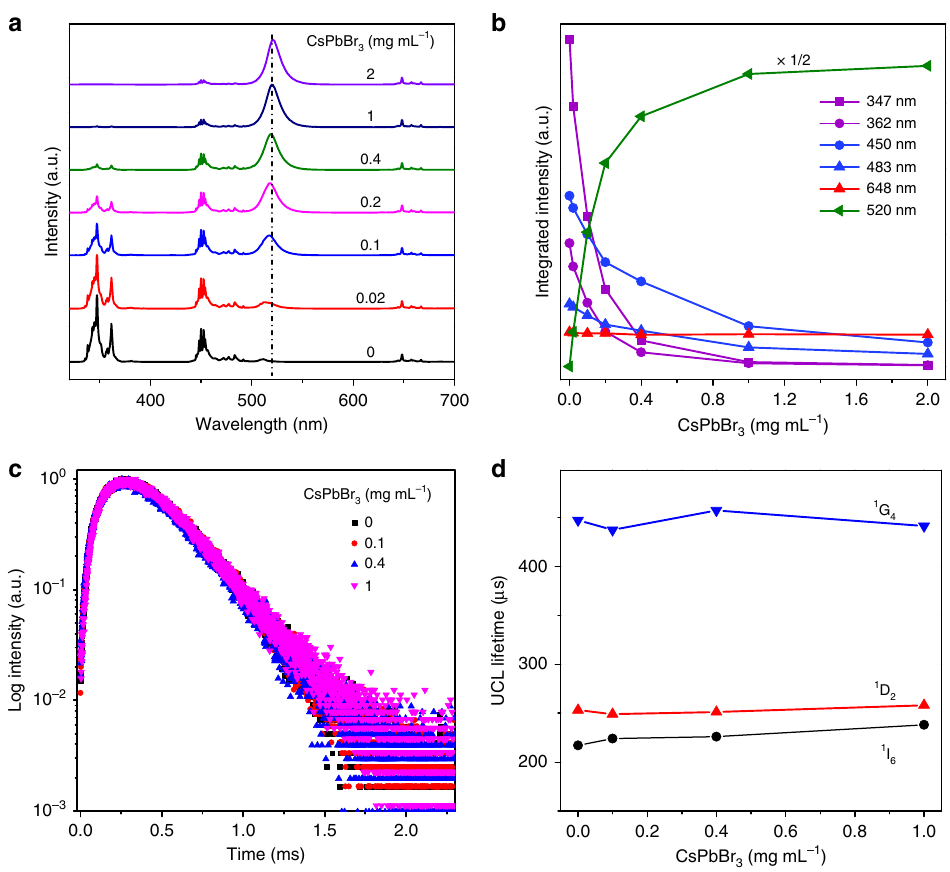
Fig. 4 Mechanistic investigation of the radiative energy transfer upconversion (RETU) process in nanoparticle (NP)-sensitized CsPbX 3 perovskite quantum dots (PeQDs). a CsPbBr 3 concentration-dependent upconversion luminescence (UCL) spectra for LiYbF 4 :0.5%Tm 3 + @LiYF 4 core/shell NP-sensitized CsPbBr 3 PeQDs with NPs concentration of 1 mg mL − 1 under 980 nm excitation at a power density of 50 W cm − 2 . b Integrated intensities of the Tm 3 + emissions at 347, 362, 450, 483, and 648 nm and the CsPbBr 3 emission at 520nm vs. the CsPbBr 3 concentration, as obtained from ( a ). c UCL decays from 1 D 3 + by monitoring the Tm 3 + emission at 362 nm in NP-sensitized CsPbBr 2 of Tm 3 PeQDs with varying CsPbBr 3 concentrations under 980 nm excitation. d UCL lifetimes of 1 I 6 , 1 D 2 , and 1 G 4 of Tm 3 + in NP-sensitized CsPbBr 3 PeQDs vs. the CsPbBr 3